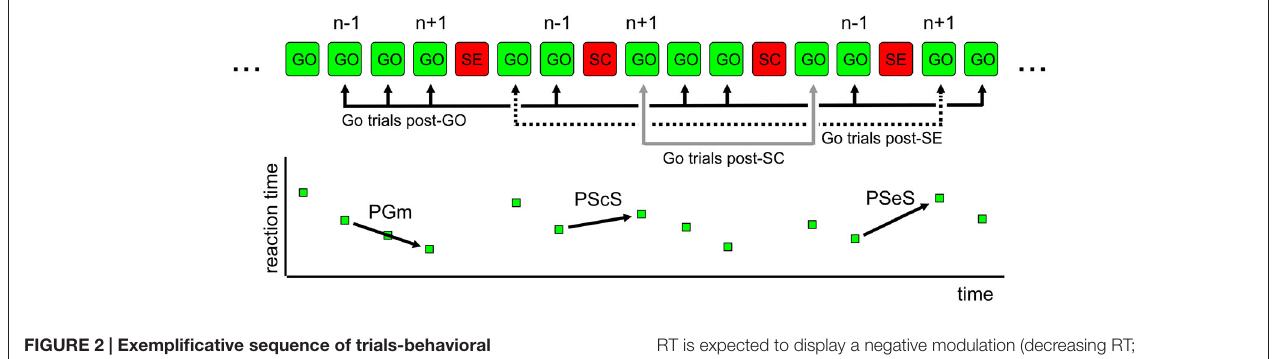
FIGURE 2 | Exemplificative sequence of trials-behavioral measures of proactive control . In a countermanding task, trials display variable RTs. The elongation of REACTION TIME (RT) is higher in Go trials after a wrong stop trial (SE; PSeS) and smaller after a correct stop trial (SC; PScS). In a sequence of Go trials (GO-GO-GO),